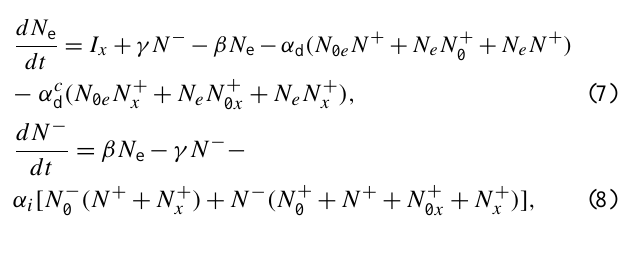
Fig. 7. Altitude profiles of electron density as obtained from GPI model at three different times for an (a) M-class and (b) X-class flare. Solid line shows the ambient profile before the beginning of the flare while the dashed and the dot-dashed lines represent the profile during the peak and at a time during recovery.